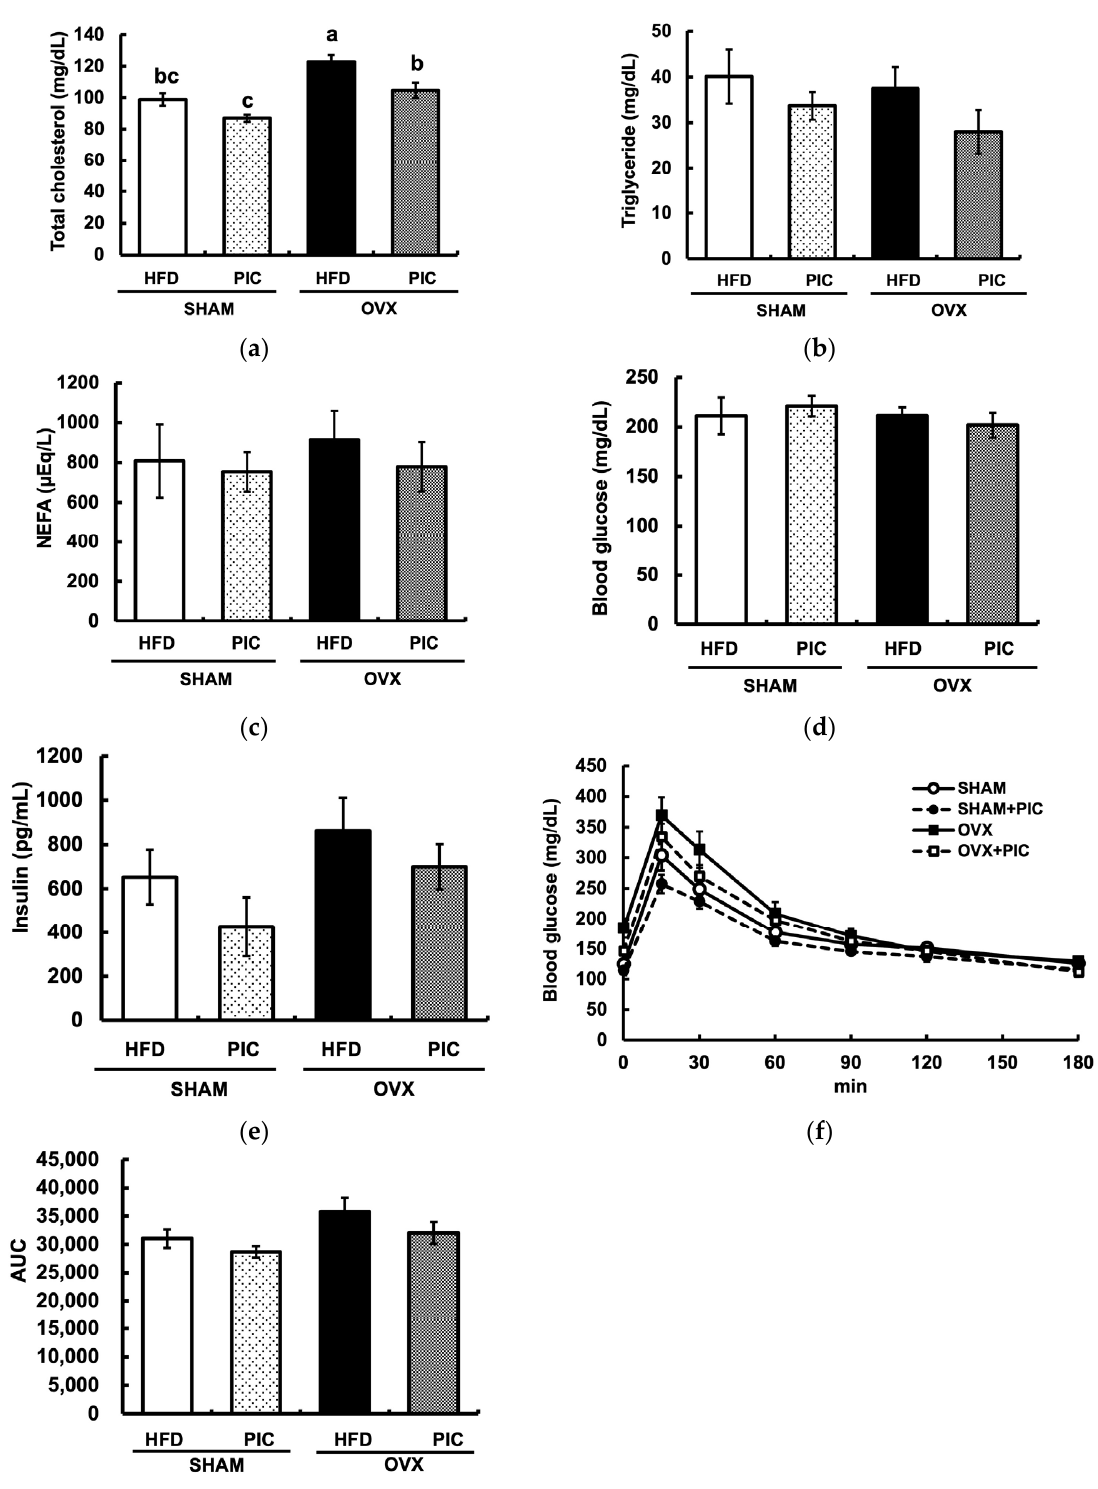
Figure 2. Effects of piceatannol on plasma biochemical parameters in ovariectomized mice fed an HFD. ( a – c ) Assessment of the serum lipid profile; ( d ) blood glucose levels and ( e ) insulin levels; ( f ) glucose tolerance test (GTT). GTT was performed one week before dissecting the mice. ( g ) area un- der the curve (AUC) of GTT. The data are presented as the means ± SE ( n = 5–6 per group), and values with different letters are considered significantly different ( p < 0.05) based on Tukey–Kramer’s test.